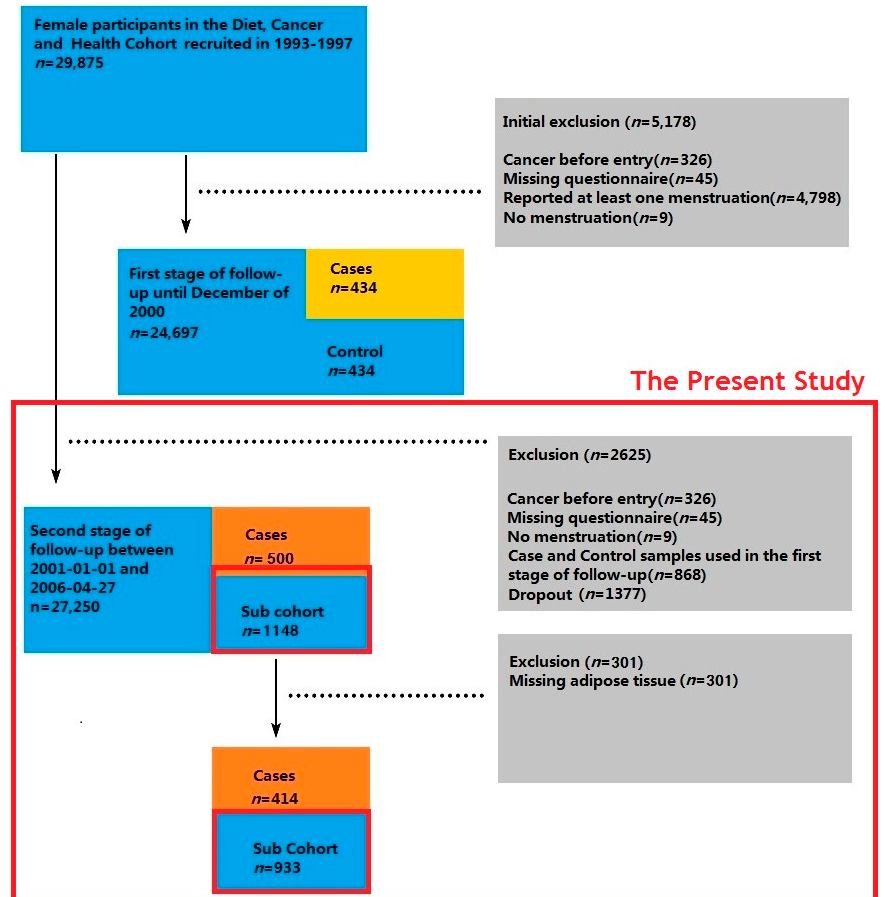
Figure 1. Case-cohort study within the Danish “Diet, Cancer and Health” cohort study between